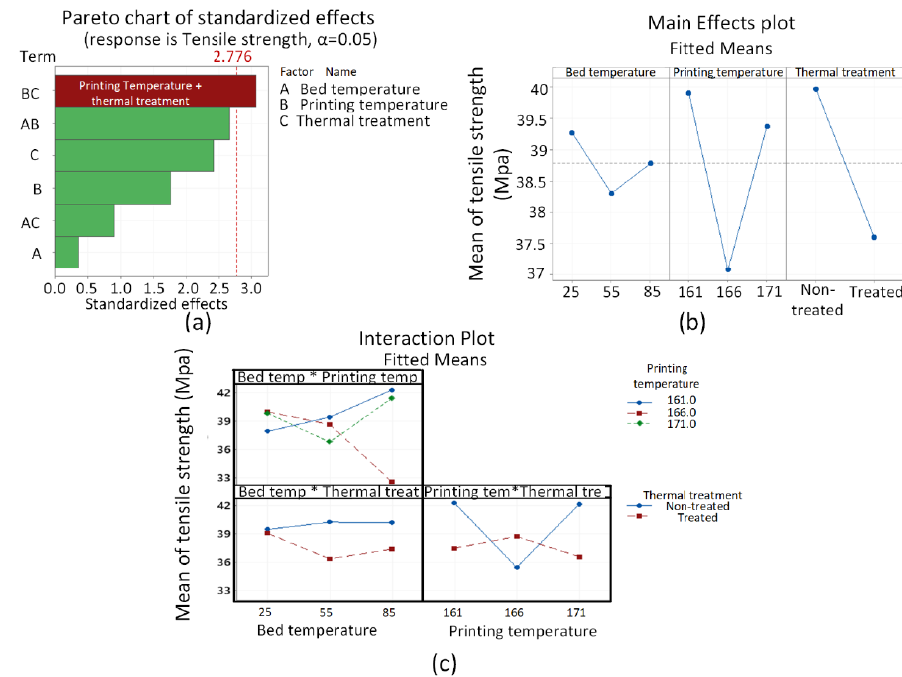
Figure 3. Results for thermal degradation: ( a ) Pareto chart, ( b ) main effect plots, and ( c ) interaction